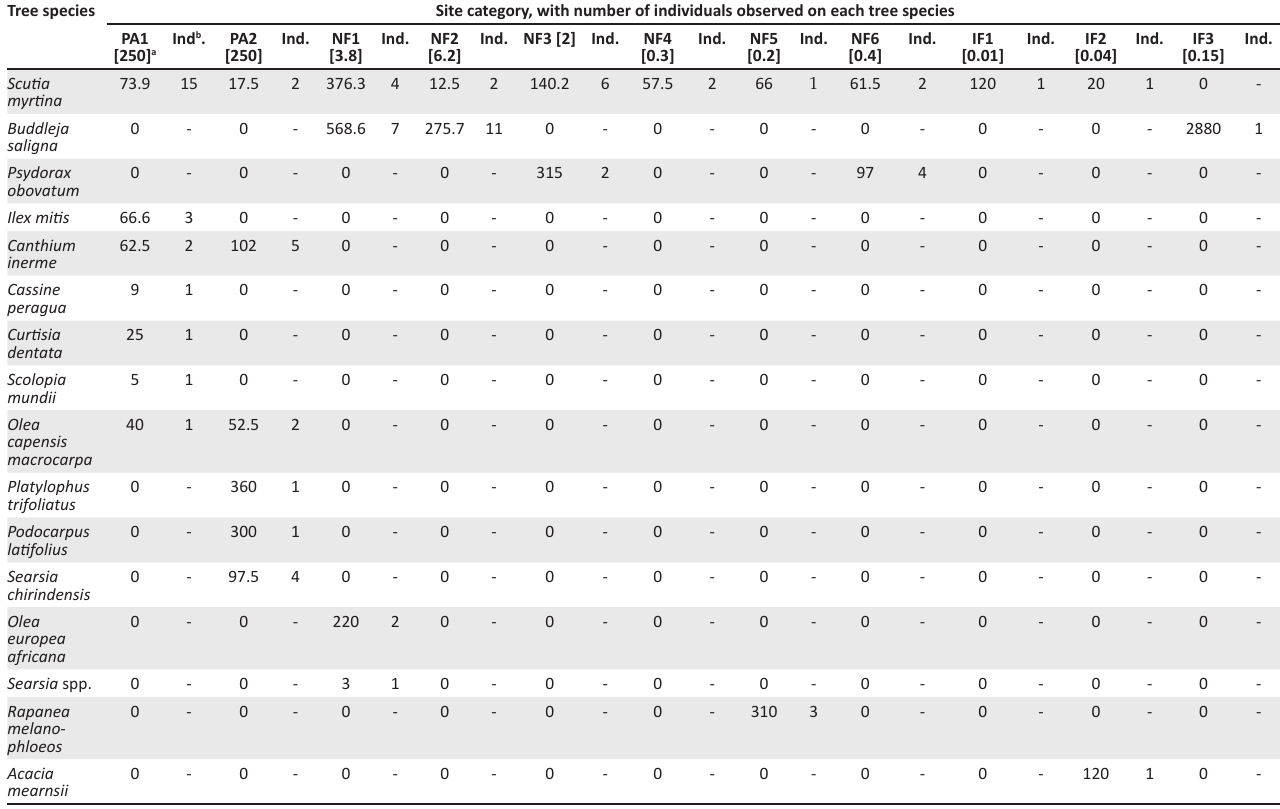
TABLE 5: Average settling time (seconds) of Charaxes xiphares occidentalis individuals on trees at 11 sites in the Grootvadersbosch Conservancy. Tree species Site category, with number of individuals observed on each tree species